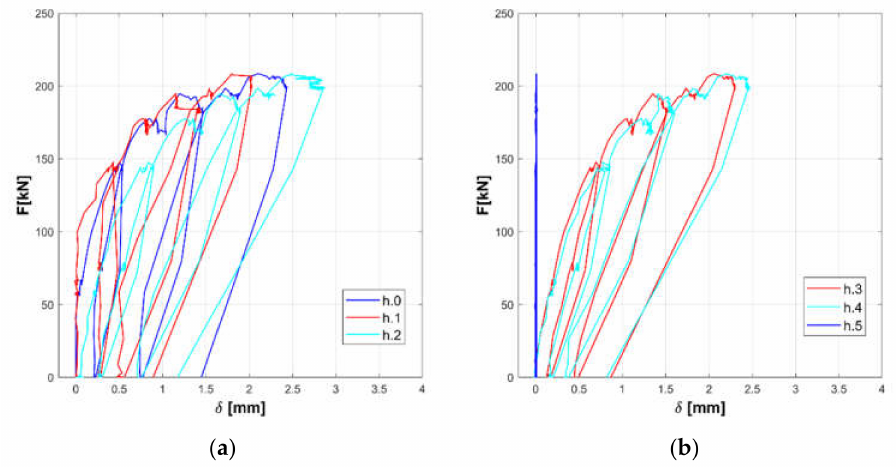
Figure 10. Experimental horizontal displacements of panel B: upper part ( a ) and lower part ( b